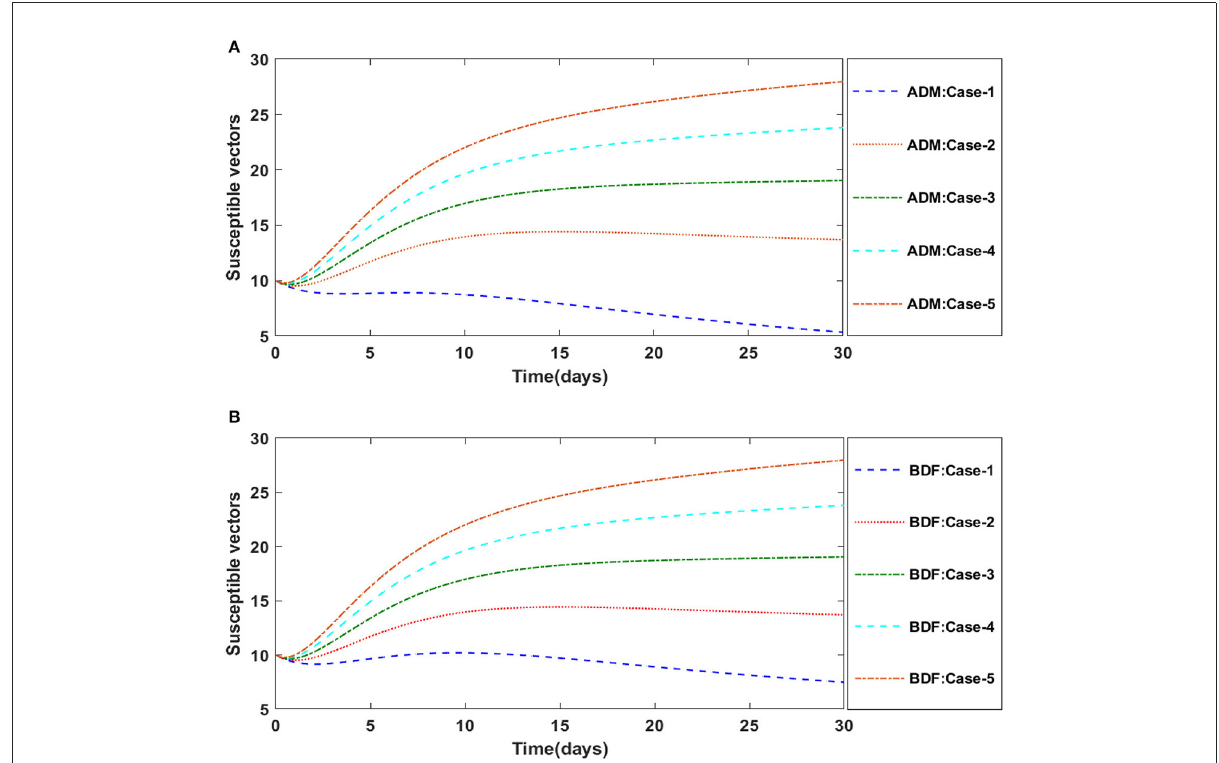
FIGURE12 (A) Dynamics of susceptible vectors for the varition in γ using ADM for model A2. (B) Dynamics of susceptible vectors for the varition in γ using ADM for model